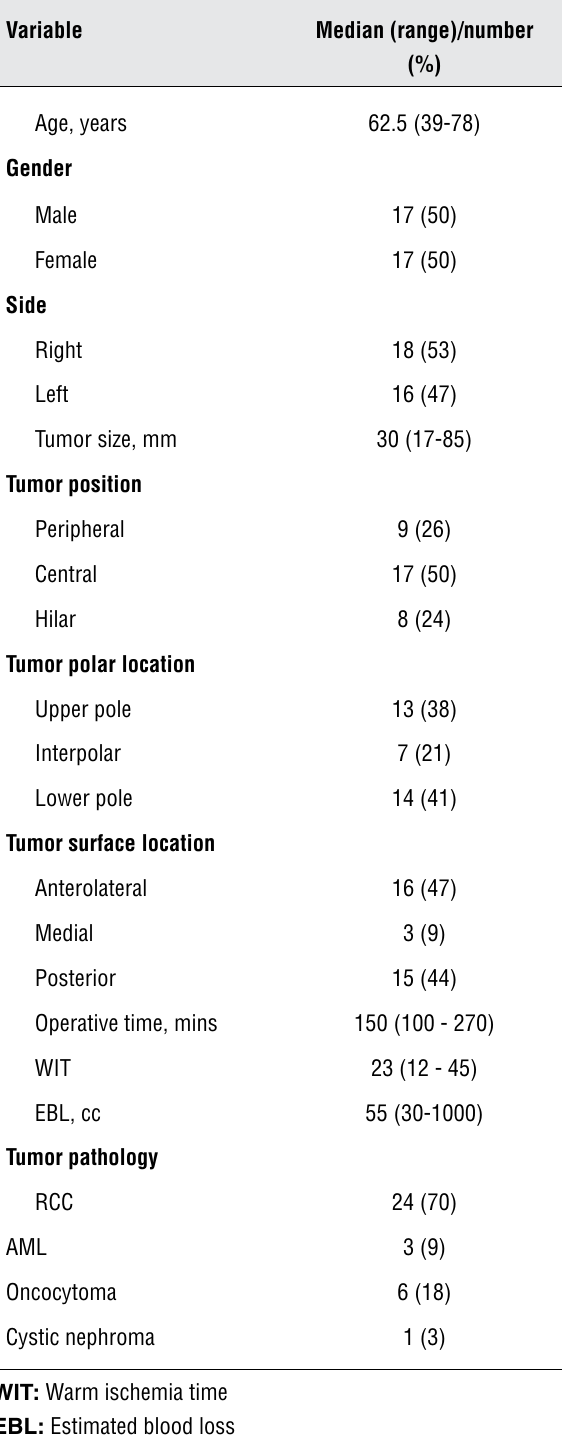
Table 1 - Patient and tumor